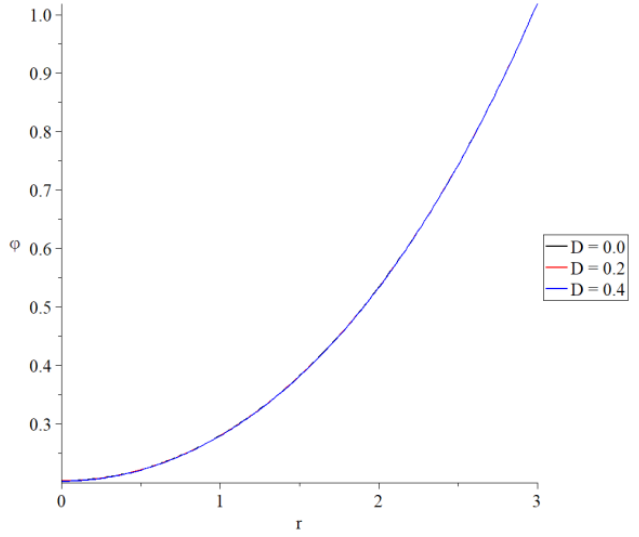
Figure 7. The distribution of the conductive temperature increment for the variance values of damage mechanics in the context of the hyperbolic two-temperature model.